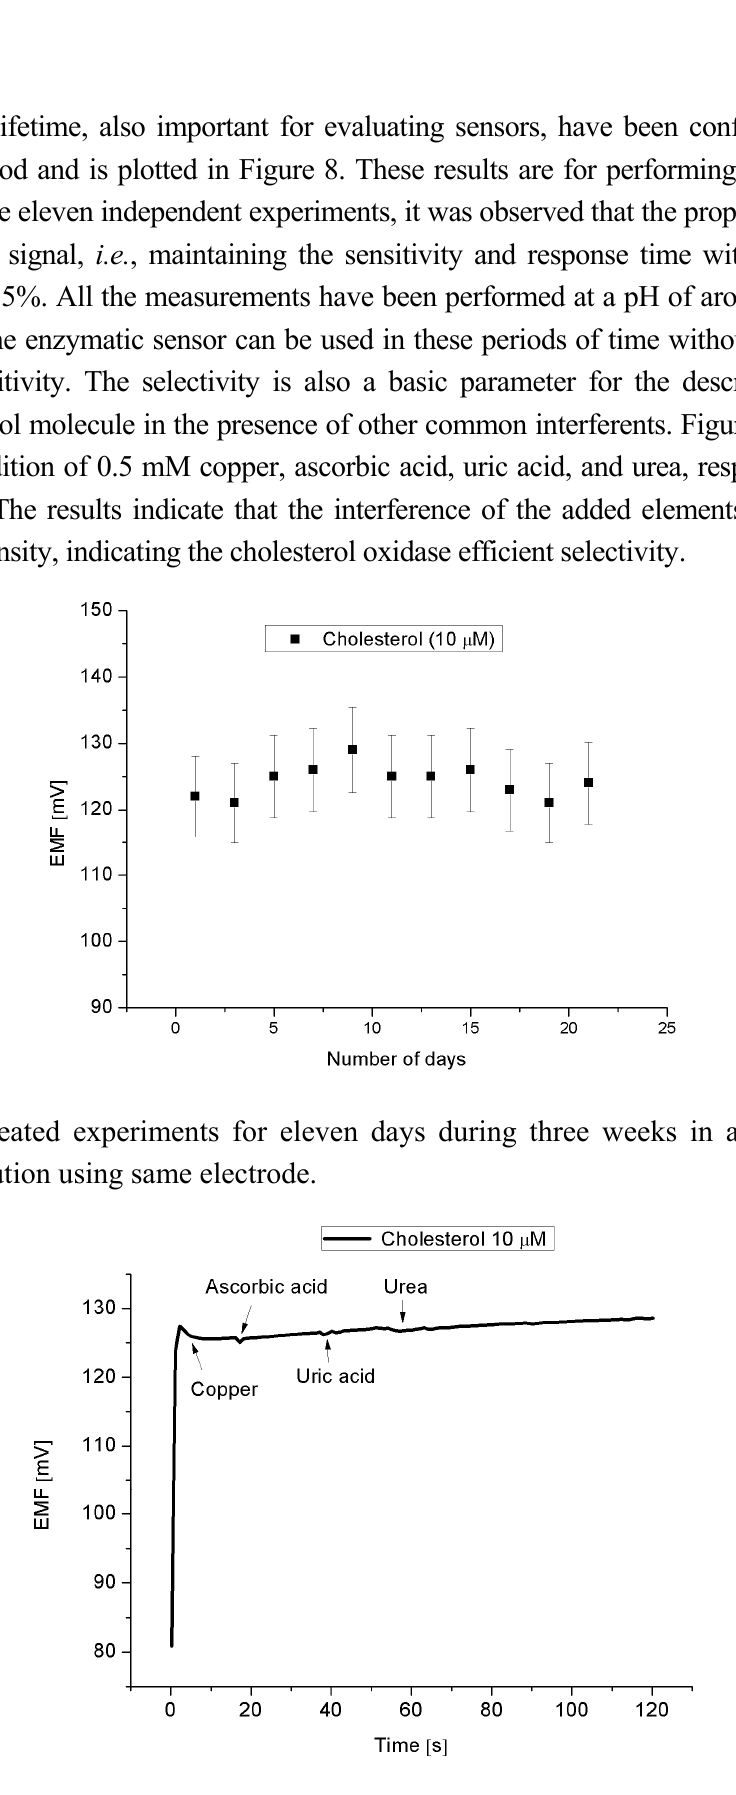
Figure 9. The EMF as a function of time with adding 0.5 mM copper, ascorbic acid, uric acid, and urea, respectively, to a 10 × 10 − 6 M cholesterol